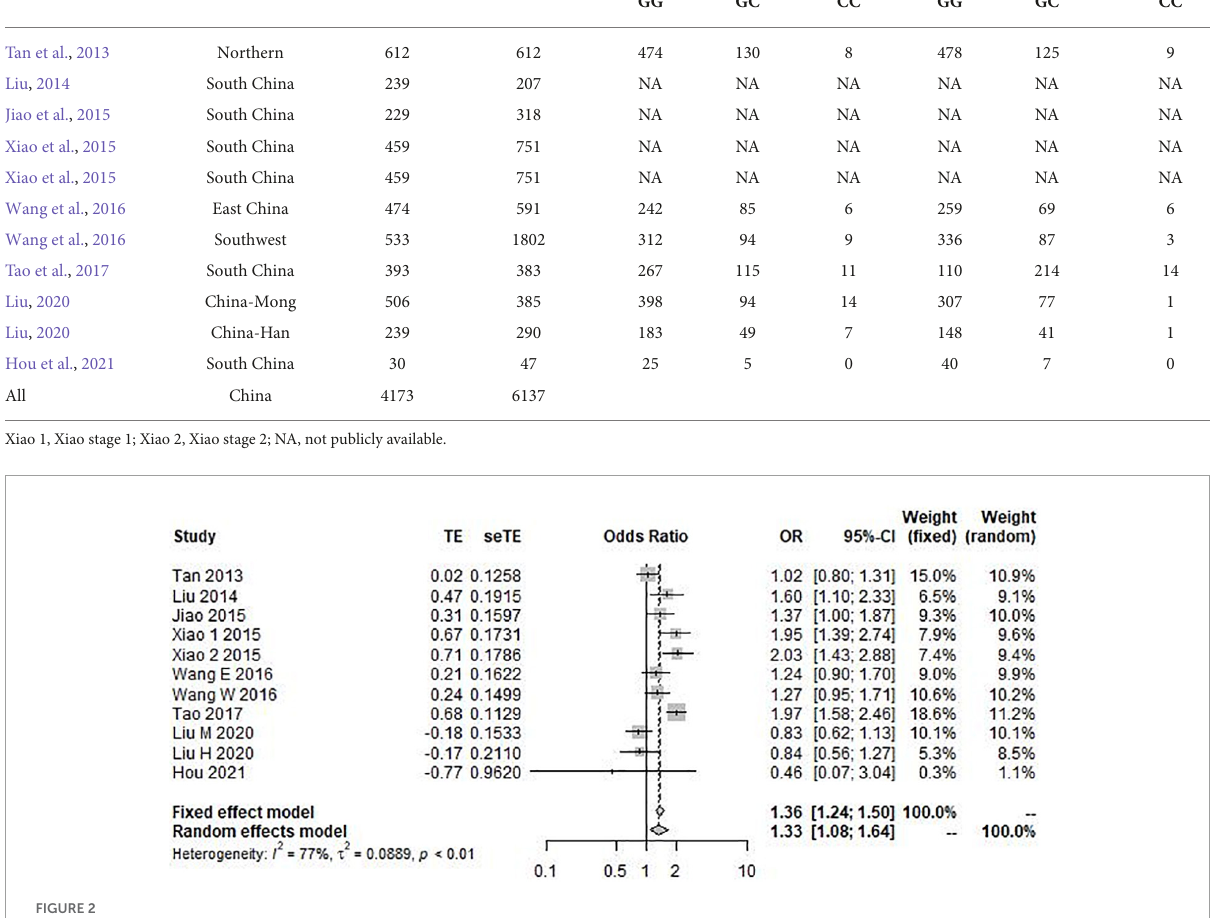
polarization of A β (Ubelmann et al., 2017). (3) CD2AP